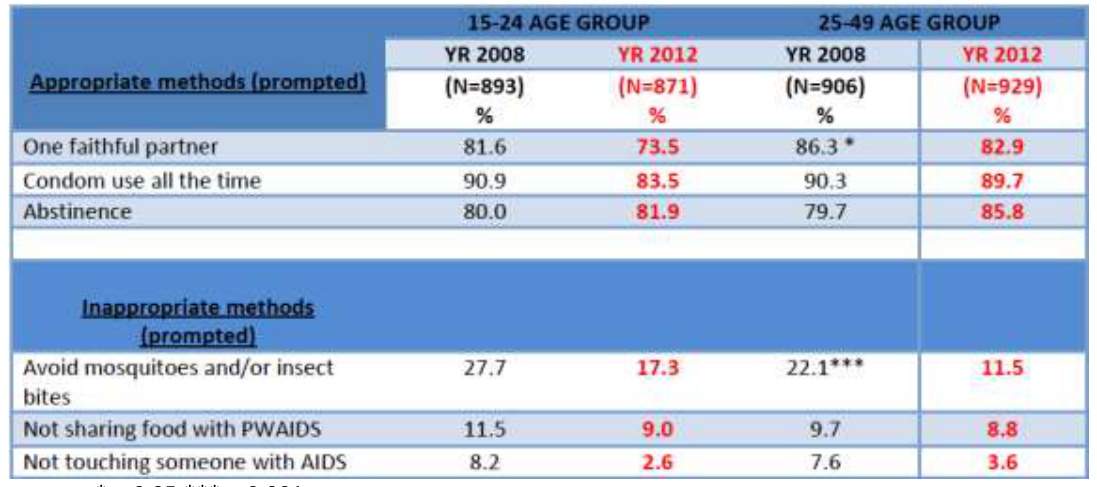
Table 3: HIV and AIDS specific knowledge by Age Year 2008 VS Year